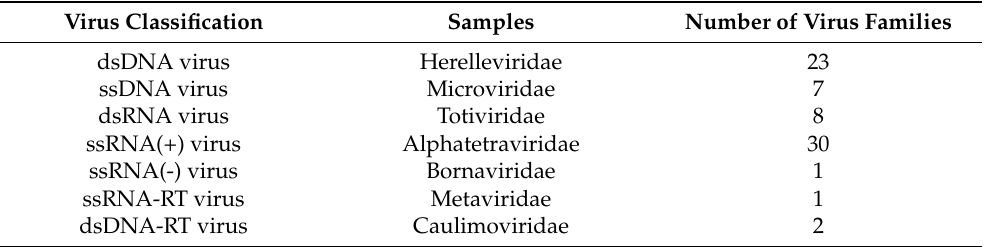
Table 4. Baltimore virus taxonomy.